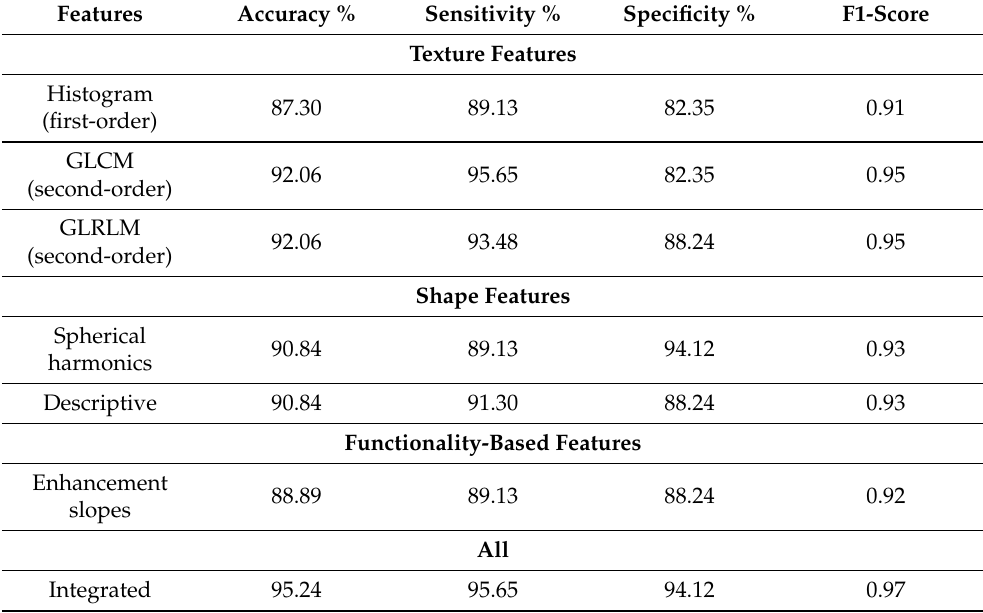
Table 2. Comparison of the suggested CAP system’s diagnostic performance using the individual features with a tuned SVM classifier, looking at accuracy, specificity, sensitivity, and